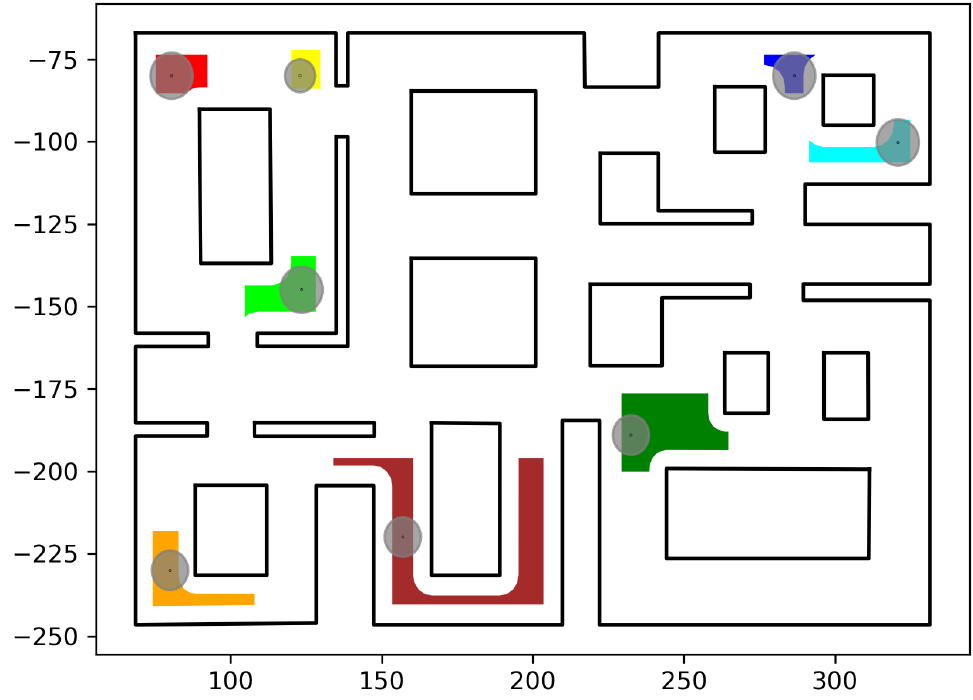
Figure 10. The initial robot positions p init, i , i ∈ I 8 and calculated initial compound cell (cid:98) C init . Robot #1 (red); Robot #2 (green); Robot #3 (dark red); Robot #4 (orange); Robot #5 (yellow); Robot #6 (dark green); Robot #7 (blue); Robot #8 (cyan). The axes units are in